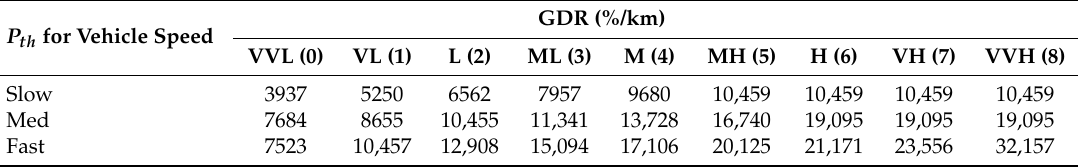
Table 5. Fuzzy rules for Power Threshold ( P th ) mapping [42].